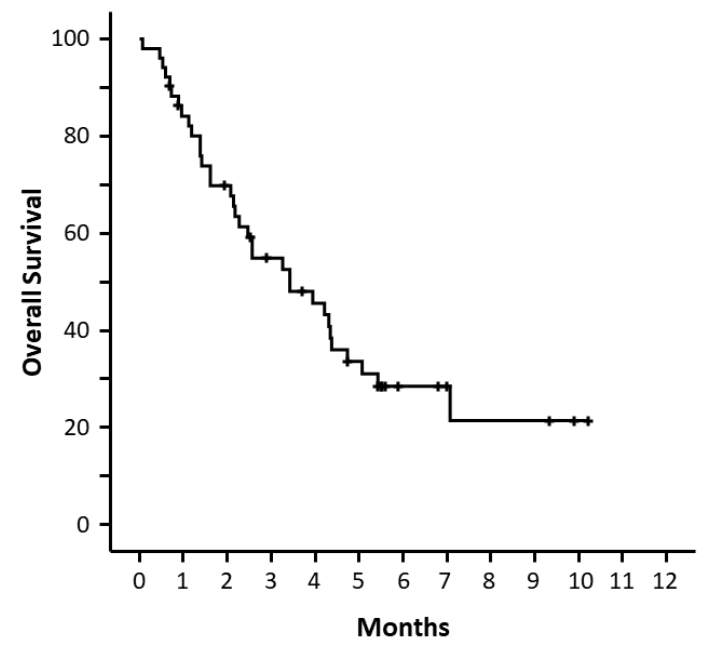
Figure 1. Overall survival from the start of venetoclax.